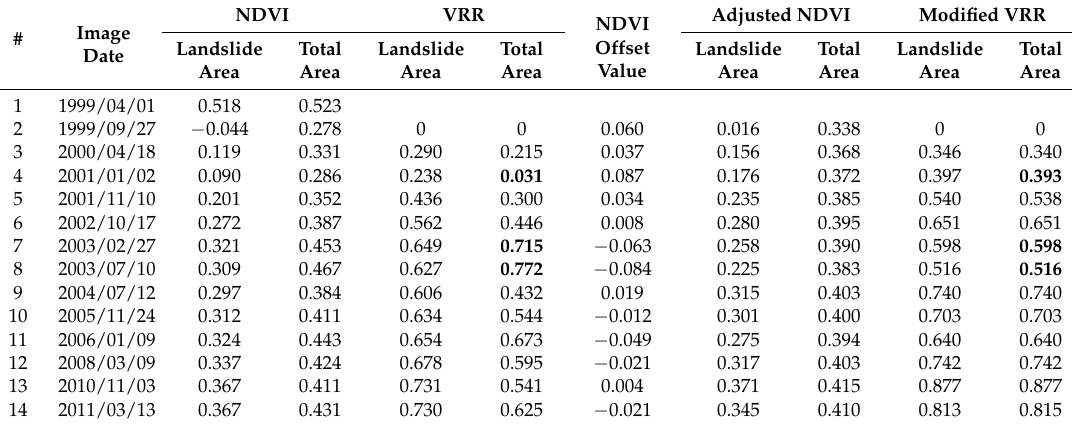
Table 2. VRR and modified VRR of the total and landslide areas. Image date is provided in yyyy/mm/dd format.